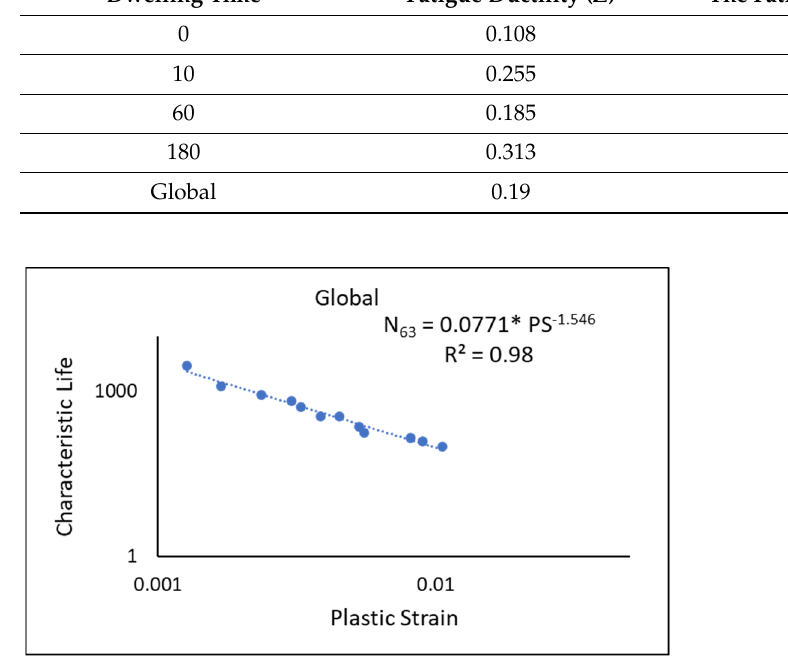
Figure 29. Characteristic life (global Coffin–Manson equation) vs. plastic strain for SAC305 joints at various dwelling times on a log–log scale.